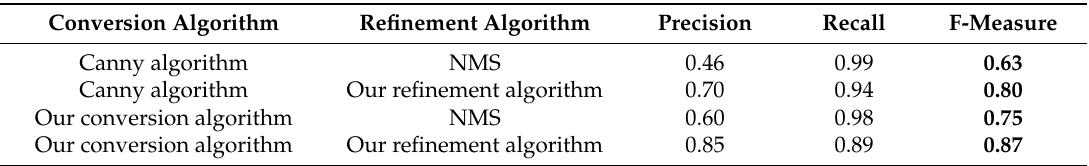
Table 3. The performance of training set generated by different conversion methods and performance comparison of different refinement